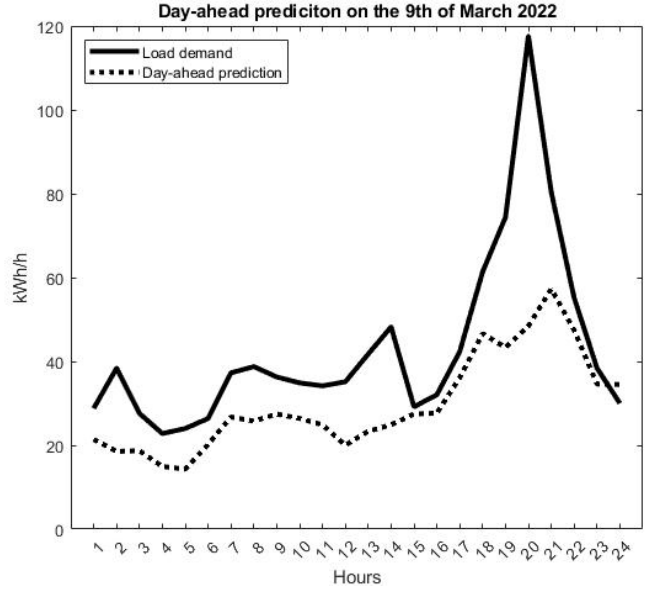
Figure 7. The mobility house’s load demand profile and the day-ahead predicted load demand profile on the 9th of March 2022, which was the day with the highest peak in load demand in the testing data set.